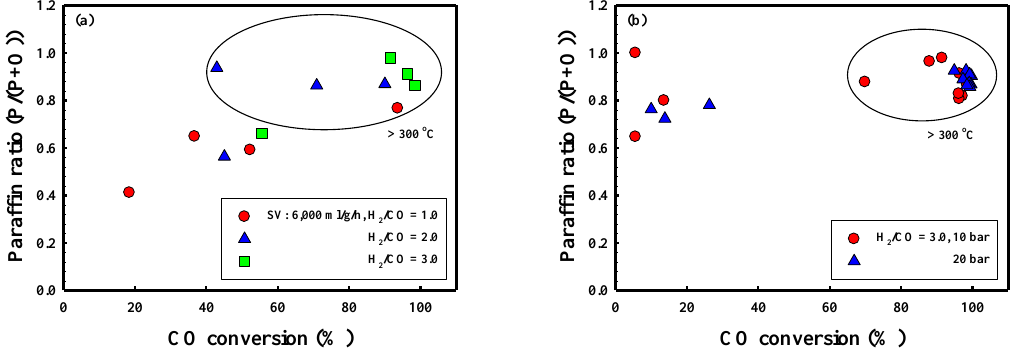
Figure 6. Paraffin ratio of the FT catalyst (5Co- 15Fe/γ -Al 2 O 3 ) as a function of CO conversion at Figure 6. Para ffi n ratio of the FT catalyst (5Co-15Fe / γ -Al 2 O 3 ) as a function of CO conversion at di ff erent different operating conditions: ( a ) effect of H 2 /CO ratio at SV of 6,000 ml/g/h, and ( b ) effect of reaction operating conditions: ( a ) e ff ect of H 2 / CO ratio at SV of 6000 ml / g / h, and ( b ) e ff ect of reaction pressure pressure at H 2 /CO ratio of 3.0. at H 2 / CO ratio of 3.0. Table 2. Summarization of catalytic performance over FT catalyst (5Co-15Fe/ γ -Al 2 O 3 ) at different space velocity, reaction pressure and temperature.